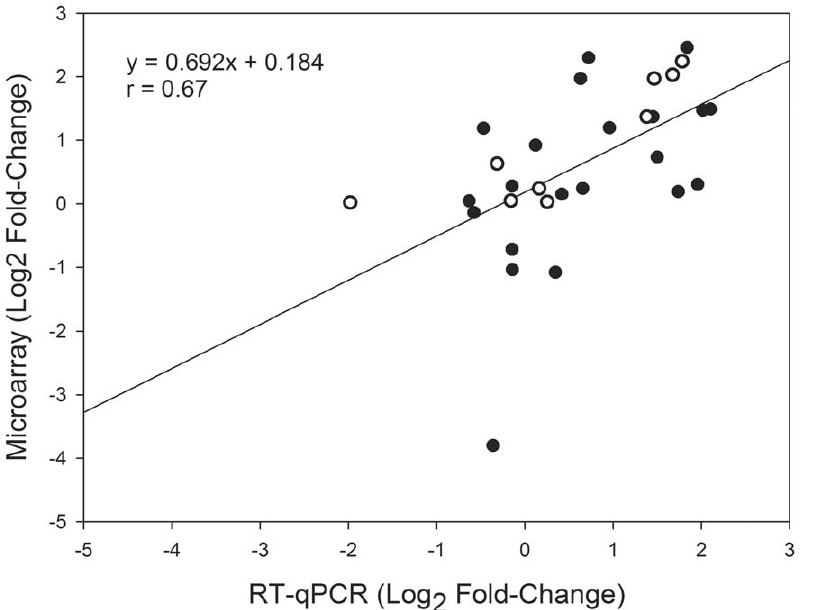
Figure 2. Correlation of gene expression changes measured using DNA microarray analysis and quantitative reverse transcription PCR (RT-qPCR). The average log2 fold-change values were used, and each point represents the gene expression in a genotype. Open circles correspond to expression using in RT-qPCR the same RNA samples as were used for microarray experiments. Black circles correspond to expression in RT-qPCR experiments using RNA that was obtained from new biological replicates. Spearman correlation coefficient (r) is shown in the graph.